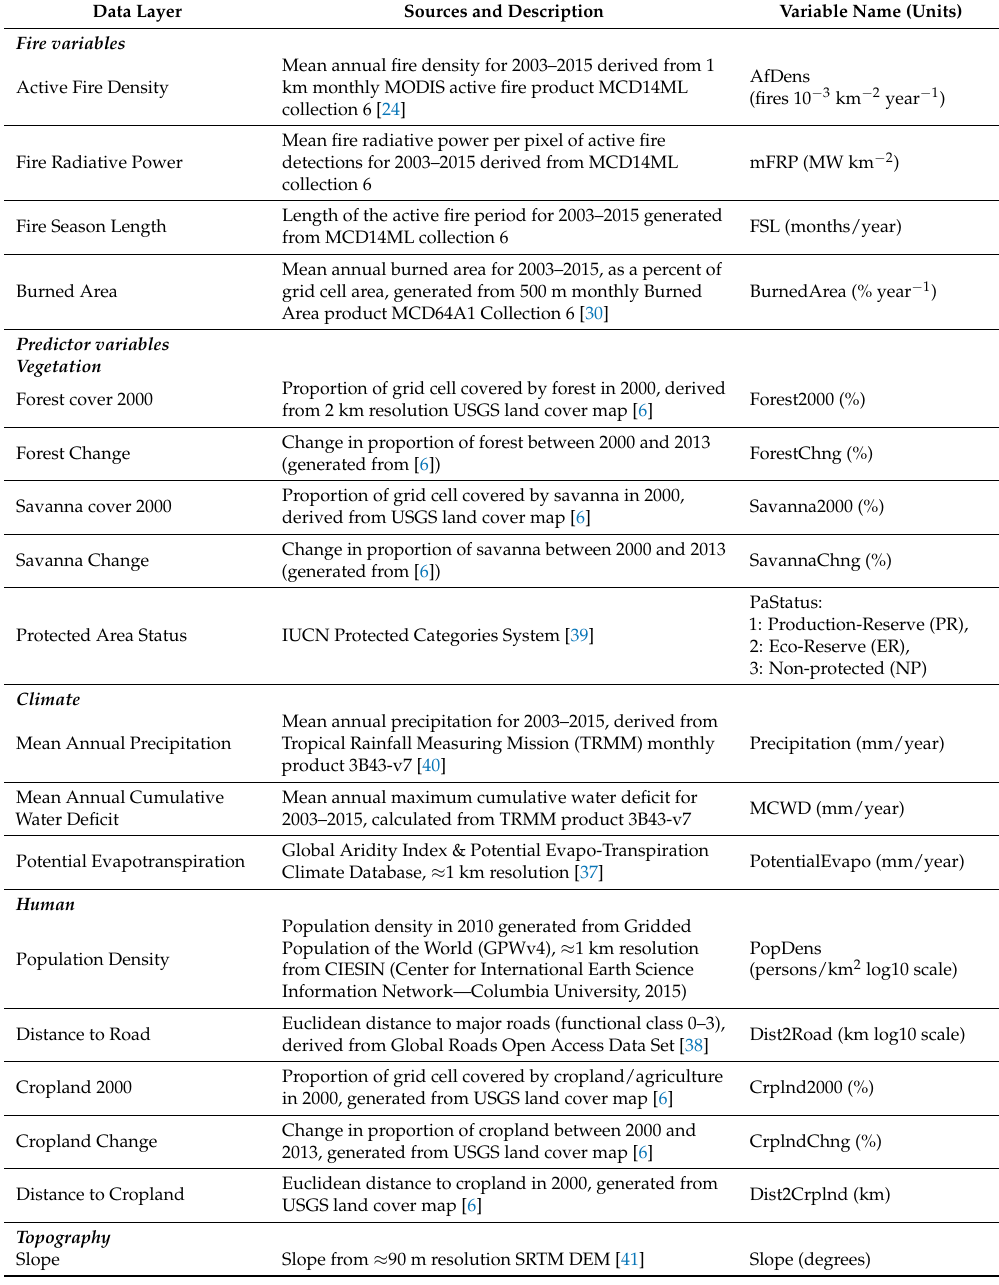
Table 1. Data layers used in the analyses. All variables were re-scaled to the TRMM spatial resolution of 0.25 ◦